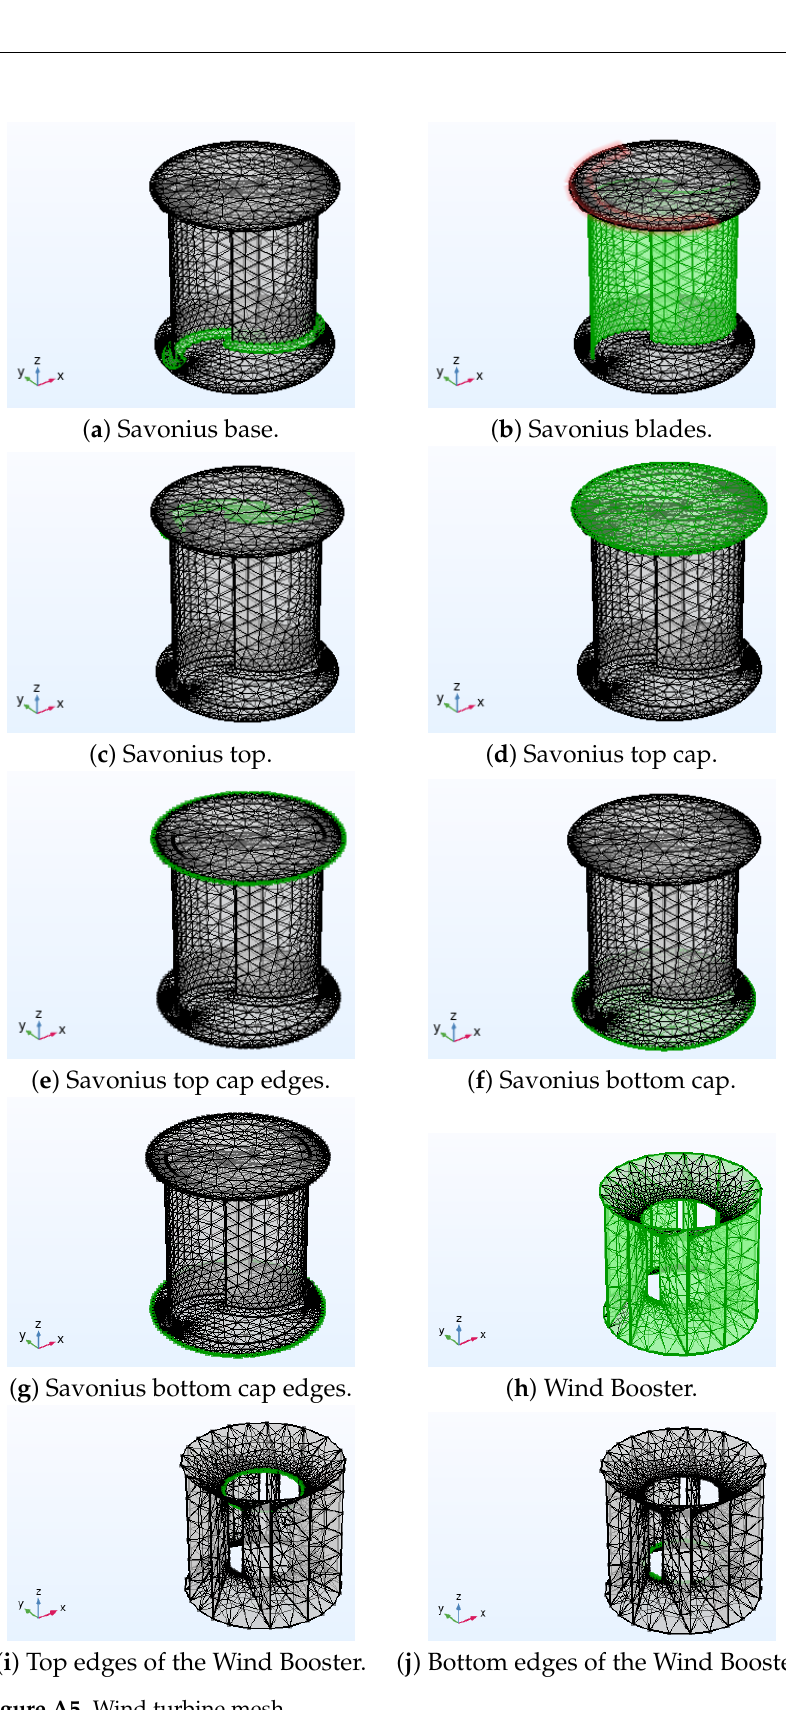
Figure A5. Wind turbine